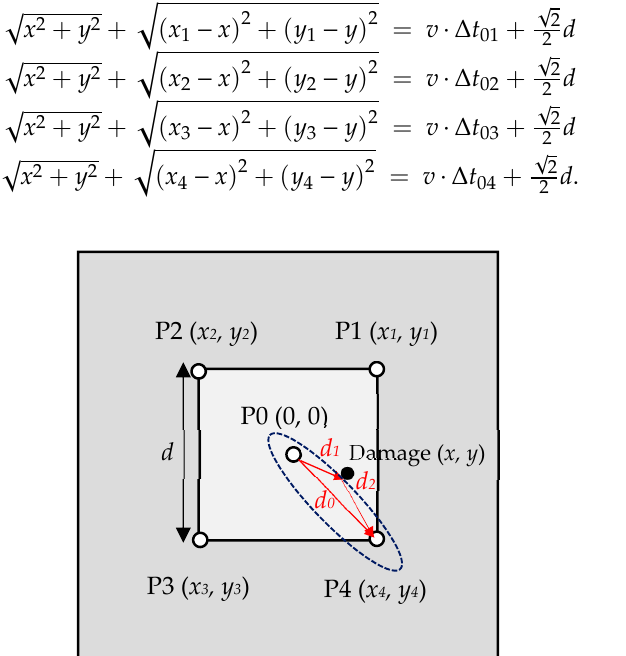
Figure 1. Damaged plate with lead zirconate titanate (PZT) transducer configuration and an ellipse tangent to the damage.